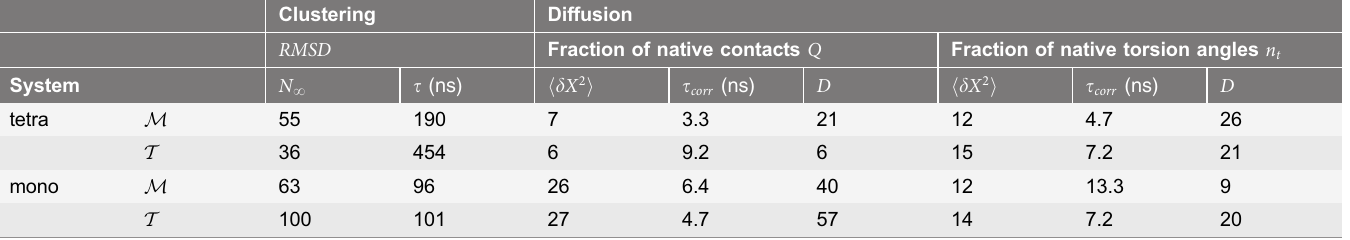
Table 2. Clustering: maximum number of clusters N ? and their characteristic saturation time t